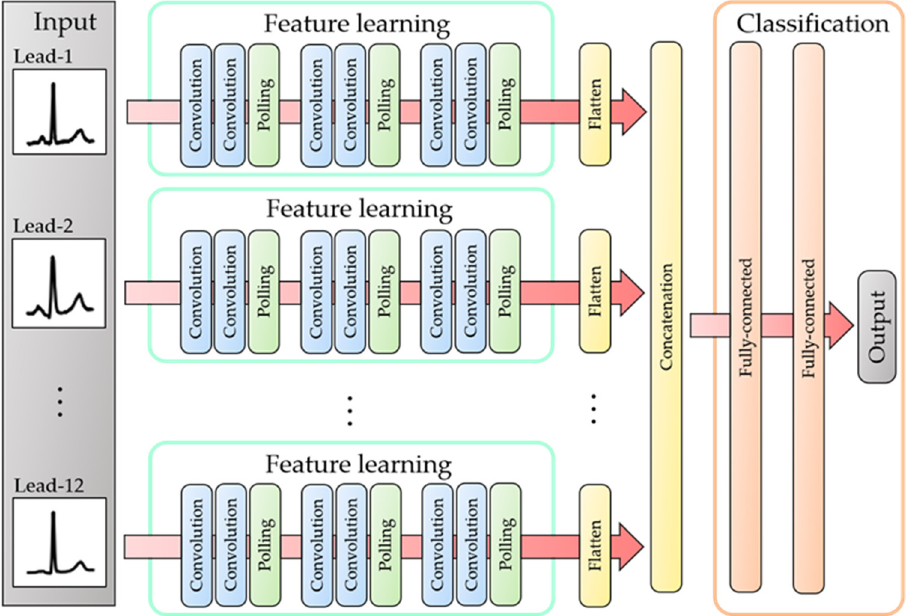
Figure 2. Architecture of proposed CNN model. Table 2. Details of the structure of proposed CNN